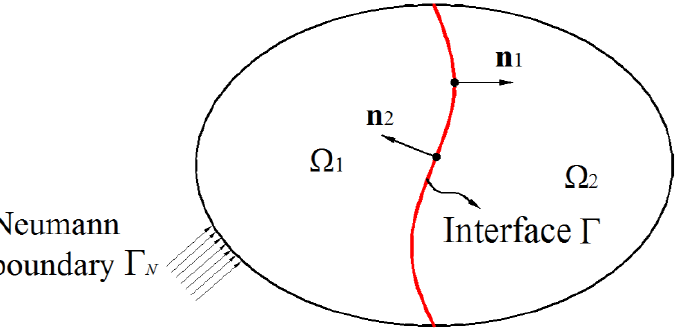
Figure 1. The involved wave propagation domain in which non-homogeneous media are consid-